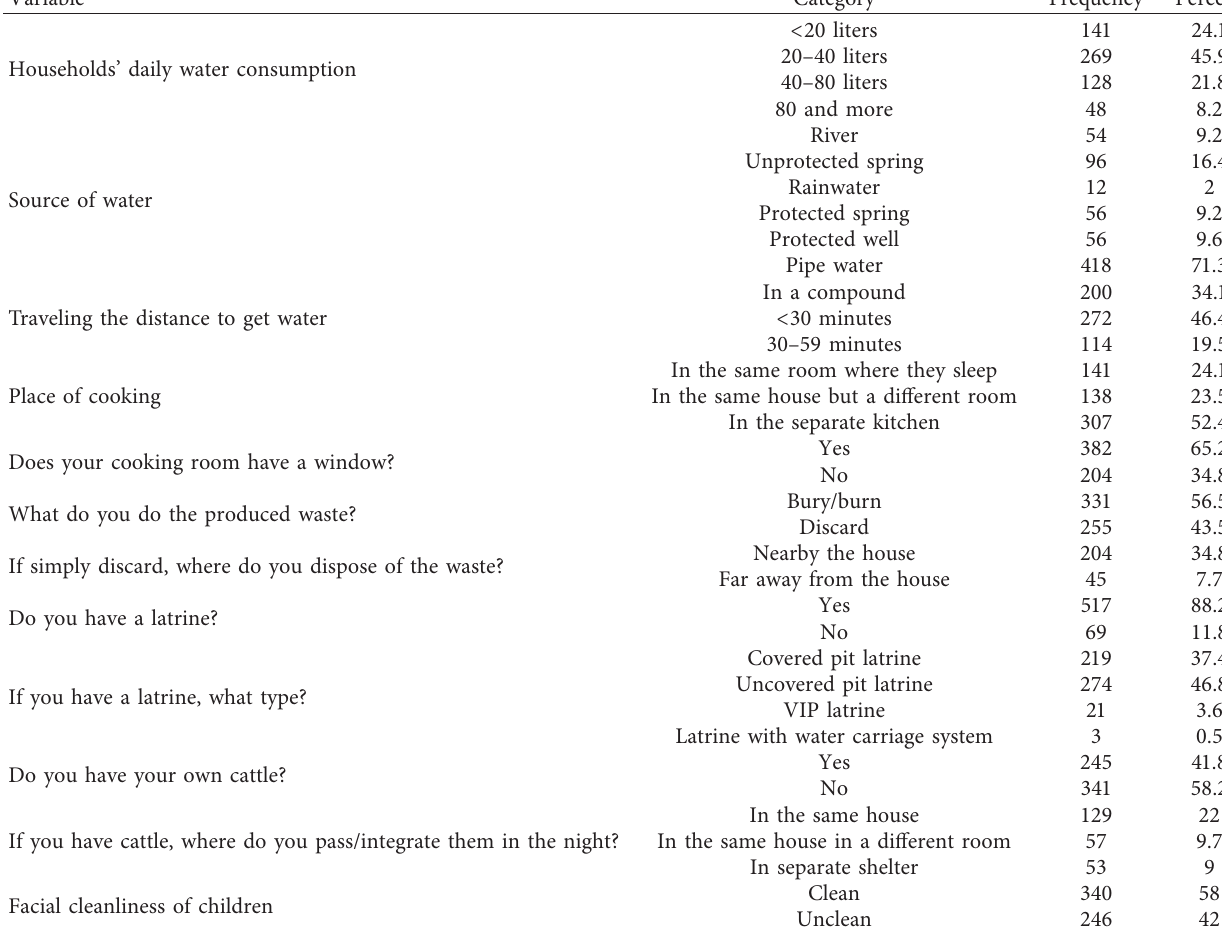
Table 3: Practice of respondents towards trachoma in Areka Town in Southern Ethiopia, 2018 ( N �